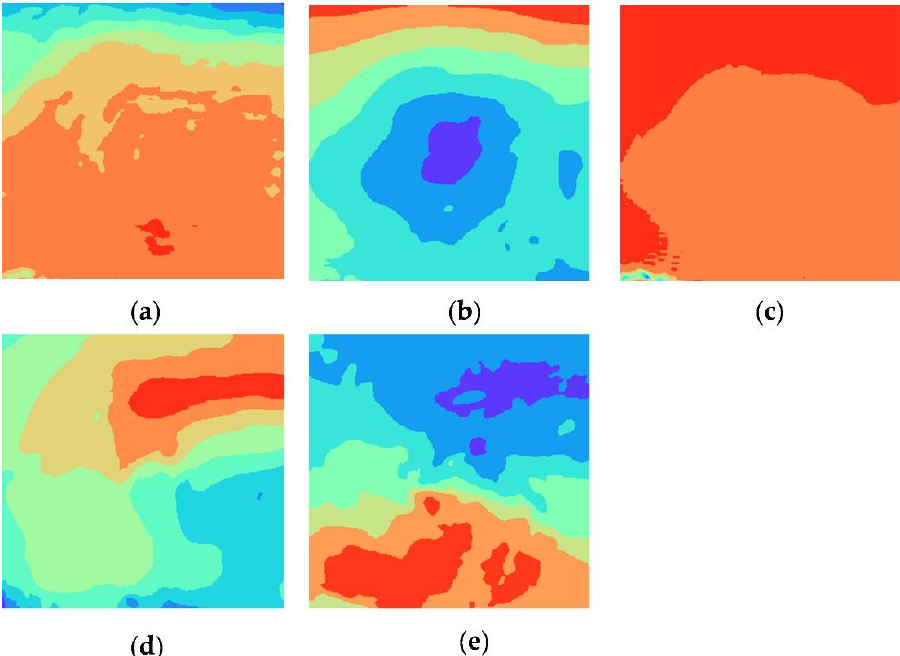
Figure 2. Heat maps of physical variables: ( a ) 2 m dewpoint temperature; ( b ) mean sea level pressure; ( c ) surface pressure; ( d ) significant height of combined wind waves and swell; ( e ) 10 m u-component of wind.